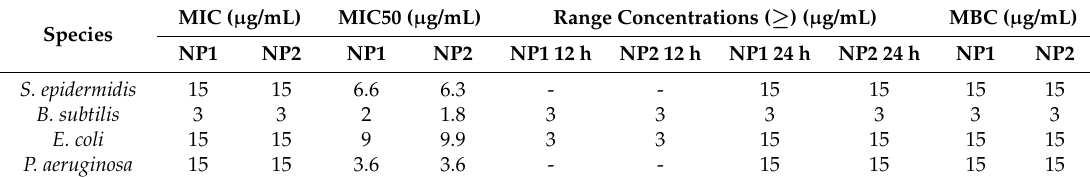
Figure 6. Comparative 3D representation of the dose response effect of nanoparticles variation I (NP1) and II (NP2) concentrations against bacterial pathogens that are named in Figure 5. Table 1. Summary of the broth microdilution (microtiter) efficacy tests of NP concentrations against four bacterial strains. Plot smoothing of the modeled bacterial responses after 24 or 48 h of incubation by local polynomial regression and projection to the concentration axis for the 50% of the initial OD values were implemented to interpolate MIC50 values. The loess function in programming language R [21] was applied for calculations.